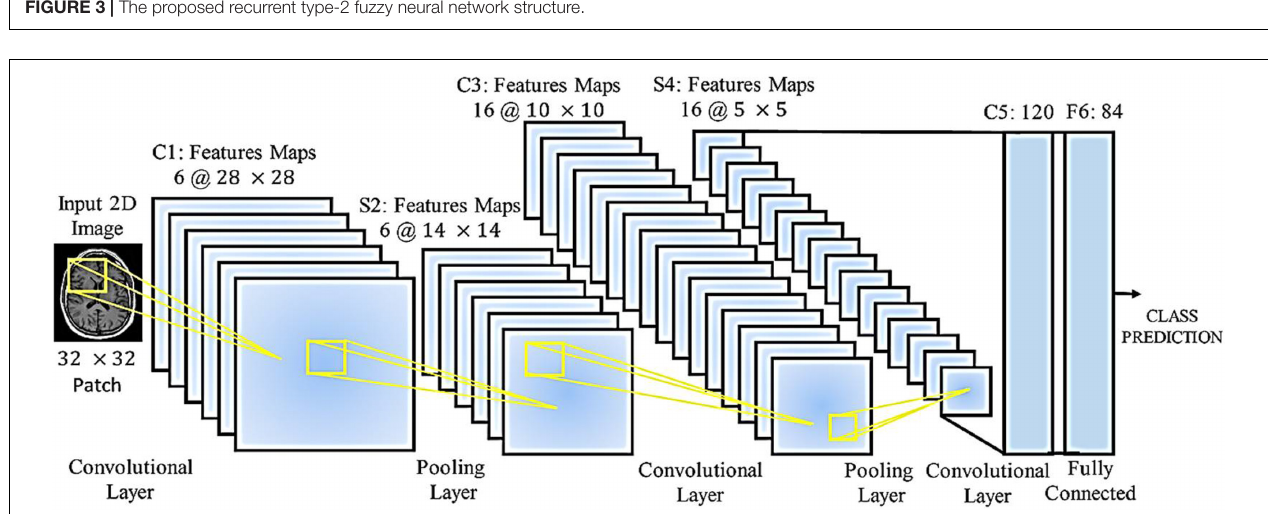
FIGURE 4 | Type-2 Fuzzy neural network operation for categorizing and processing brain